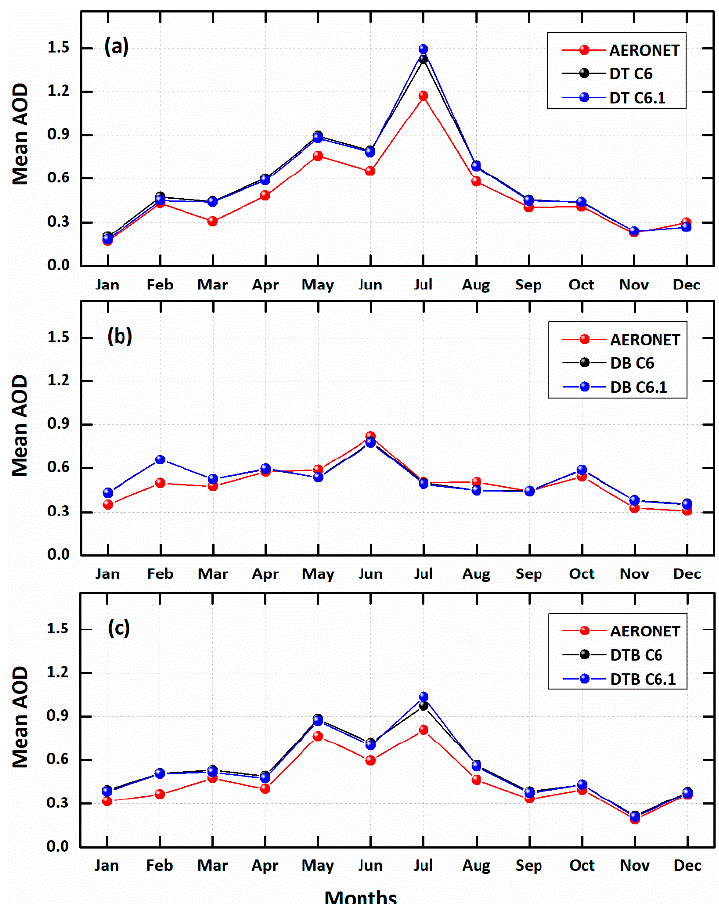
Figure 5. Temporal trends of monthly averaged collocated observations of DT AOD ( a ), DB AOD ( b ), and DTB AOD ( c ) retrievals from 2004–2014 over BTH.